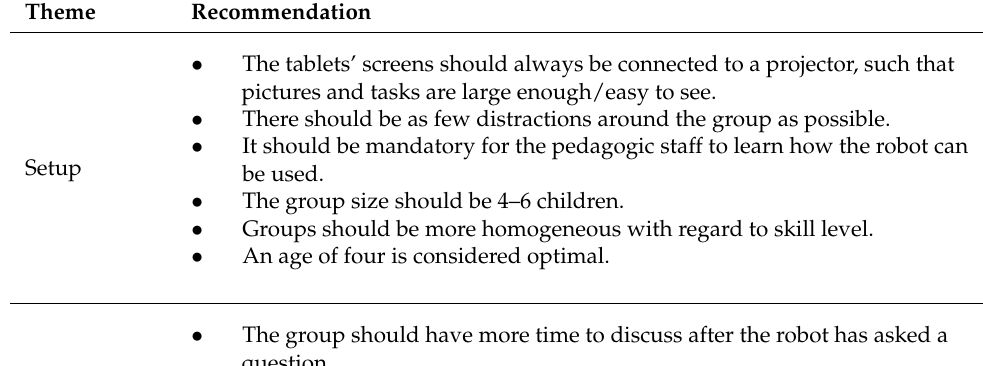
Table 6. Summary of recommendations by